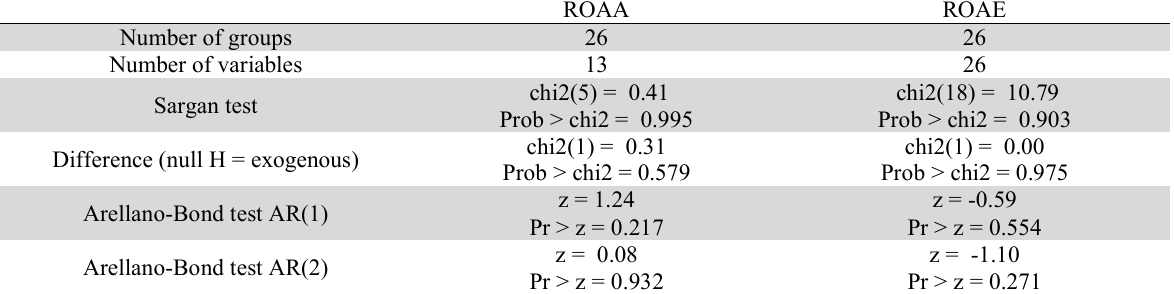
Results of Sargan and Arellano-Bond testing for 26 banks model